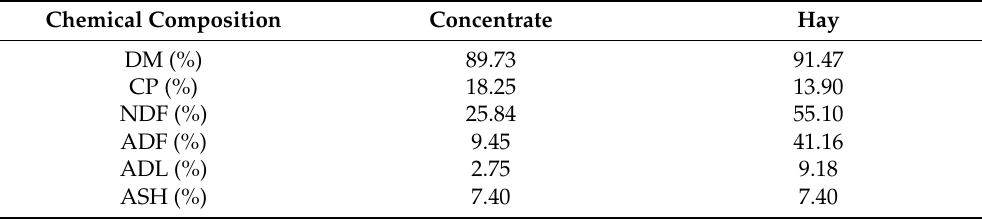
Table 1. Chemical Composition of Concentrate and Hay (% on a DM Basis) Used During the Trial. Chemical